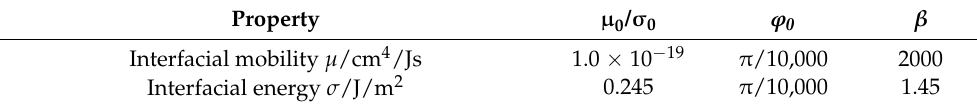
Table 1. Anisotropy parameters of interfacial energy and interfacial mobility [24,49].